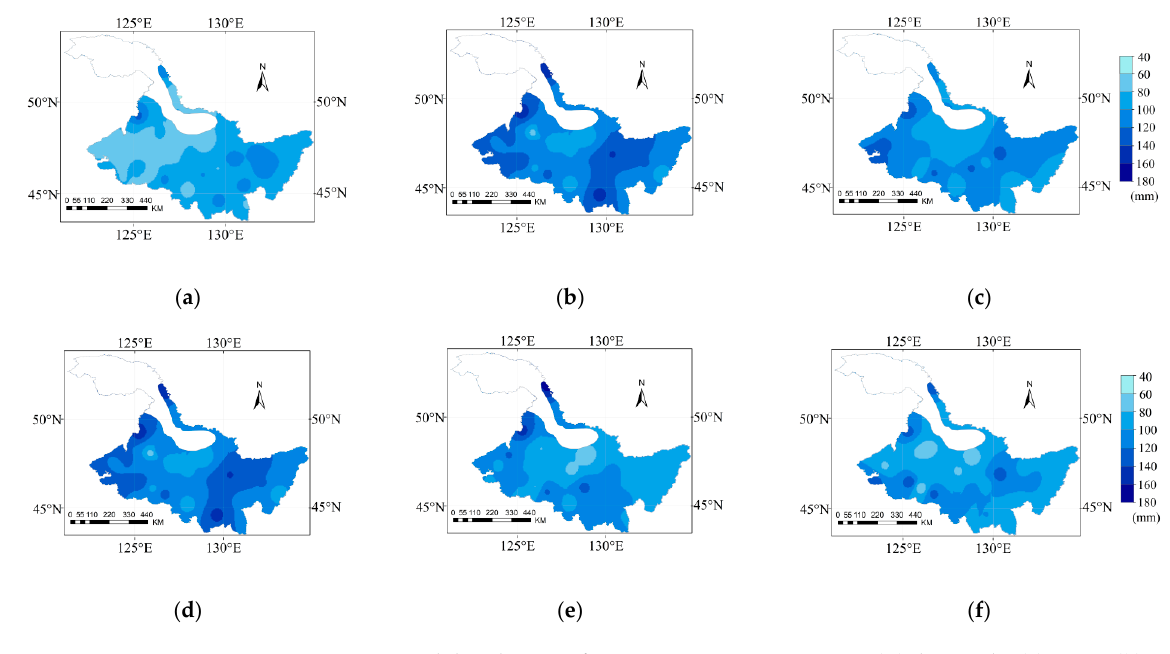
Figure 12. Spatial distribution of irrigation water requirement ( I r ) during the ( a ) 2030s, ( b ) 2050s, and ( c ) 2070s under RCP4.5, and during the ( d ) 2030s, ( e ) 2050s, and ( f ) 2070s under RCP8.5 during the soybean growth period.